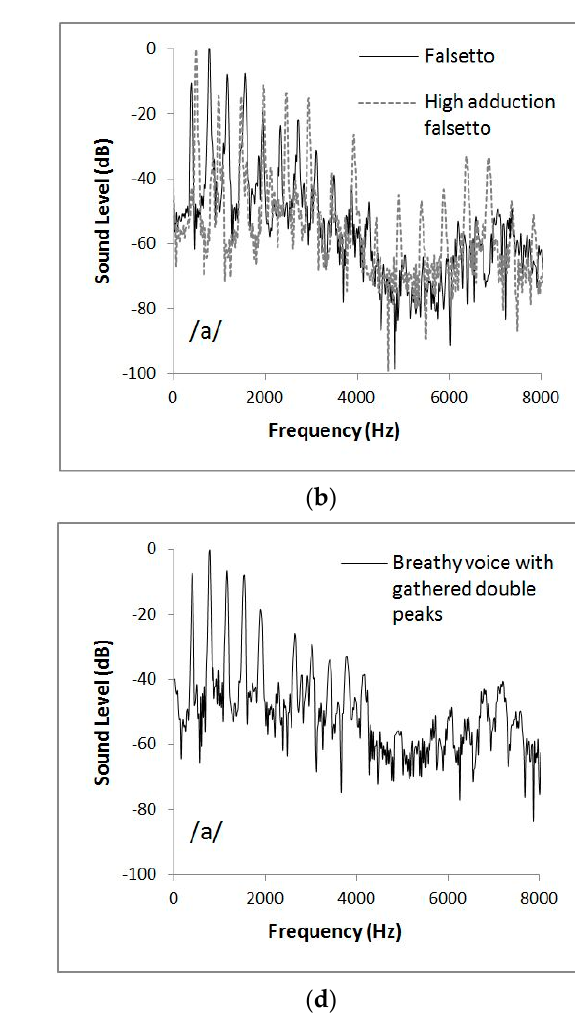
Figure 6. Spectra of modal voice, high adduction modal voice, breathy voice, untrained falsetto, and high adduction falsetto. ( a ) Spectra of modal voice and high adduction modal voice; ( b ) spectra of falsetto and high adduction falsetto; ( c ) spectrum of breathy voice with double peaks; ( d ) spectrum of breathy voice with gathered double peaks.